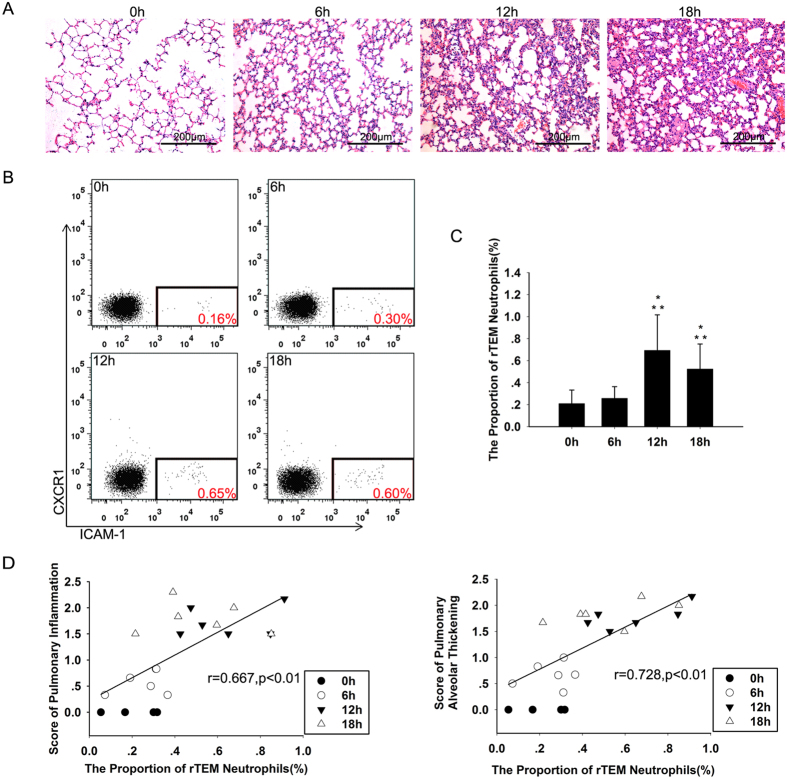
Reverse-migrated (rTEM) neutrophils are associated with lung injury in a murine model of experimental pancreatitis induced by caerulein (100 μg/kg) in combination with LPS (5 mg/kg).(A) Representative micrographs of lung tissue from control mice and mice with AP are presented. Lung tissues were taken 0h, 6 h, 12 h and 18 h after the first caerulein injection. (B) Murine neutrophils were analyzed for ICAM-1 and CXCR1 expression by flow cytometry. Example scatter plots of ICAM-1 and CXCR1 profiles are shown. The numbers in the red field show the proportion of the rTEM neutrophils, which increased significantly at 12 h and 18 h. (C) A comparison of the proportion of rTEM neutrophils in different time points (*p < 0.05 compared to the 0h group, **p < 0.05 compared to the 6h group, n = 6 at each time point). (D) An increased level of rTEM neutrophils in the peripheral blood positively correlated with score of lung injury (n = 6 at each time point; alveolar thickening: r = 0.728, p < 0.01; inflammation: r = 0.667, p < 0.01). Original magnification ×200. Mice were sacrificed 0 h, 6 h, 12 h and 18 h after the first caerulein injection.